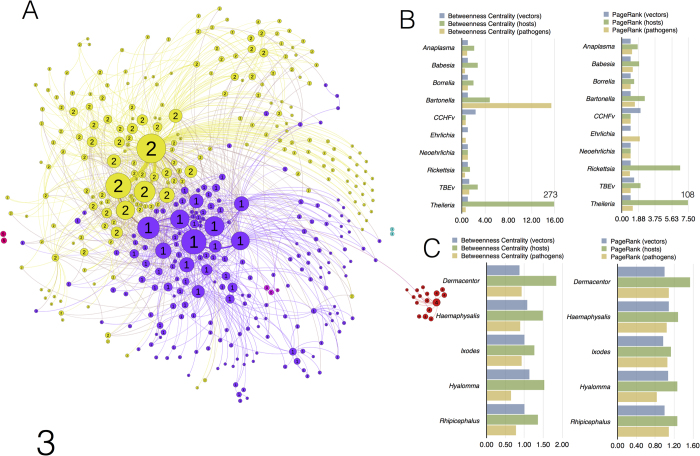
The network of ticks, vertebrates and pathogens with records from domesticated animals(a) Changes in the structure modularity of the network of ticks, pathogens, and vertebrates in the western Palearctic after the inclusion of domestic vertebrates. These changes were detected by the modularity algorithm, are represented according to the ForceAtlas2 scheme, and are randomly coloured. Complete taxonomical information appears in Supplementary Figure 2. (b) Changes in the NBC and the PR of pathogens after the inclusion of domestic vertebrates in the network. (c) Changes in the NBC and the PR of ticks after the inclusion of domestic vertebrates. In (b) and (c), histograms reflect domestic rates of change (1 = no change). Rates of change of the genus Theileria are not drawn to the same scale as the other pathogen genera. Change values are included in the charts.